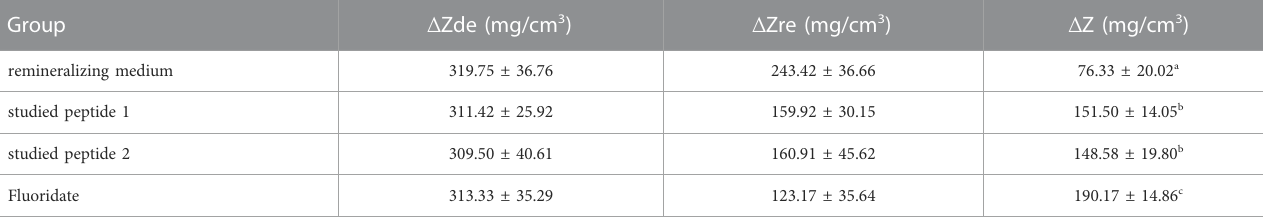
TABLE 1 Results of mineral loss and gain of the enamel samples. Group